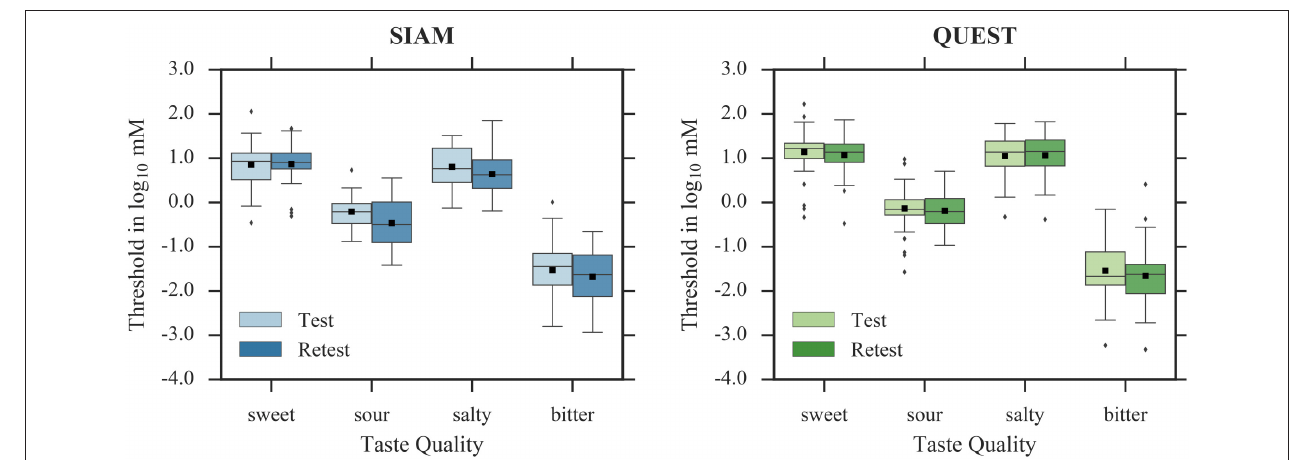
FIGURE 4 | Threshold estimates in test and retest for SIAM (left) and QUEST (right) . Whiskers are 1.5 × interquartile range. Outliers are depicted as diamonds, and sample means as black squares.